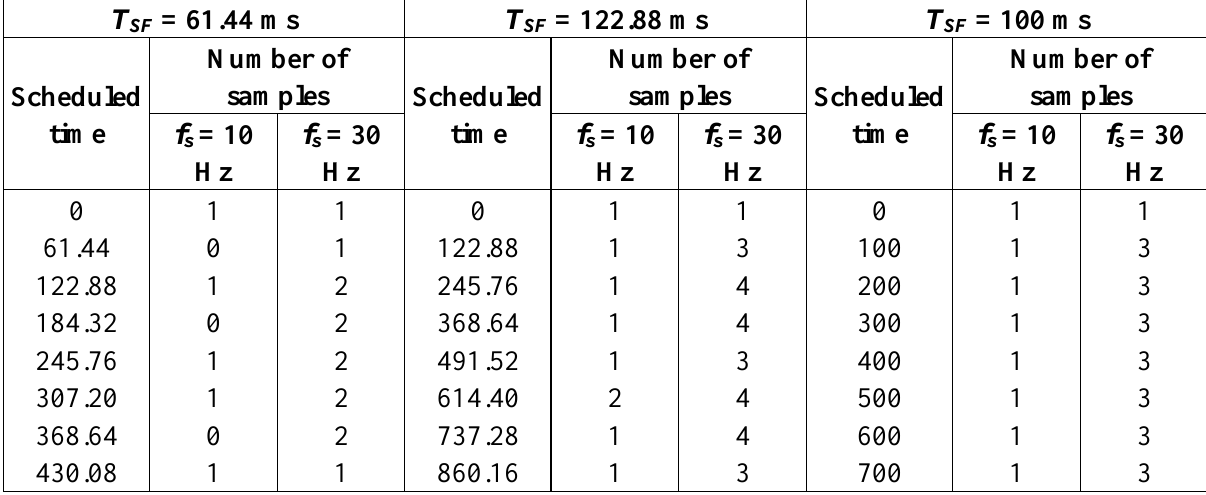
Table 3. Number of samples per packet with different superframe